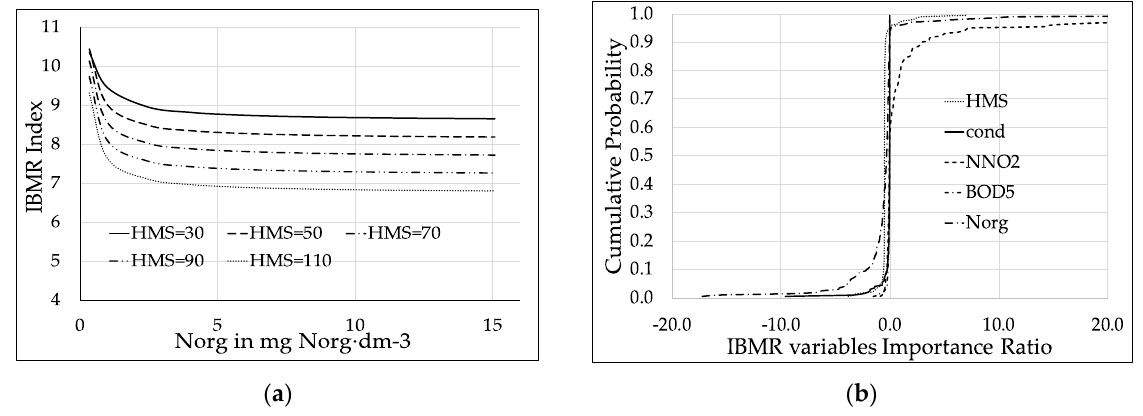
Figure 3. ( a ) HMS-organic nitrogen nonlinear relationship with IBMR; ( b ) importance ratio of independent variables with IBMR.